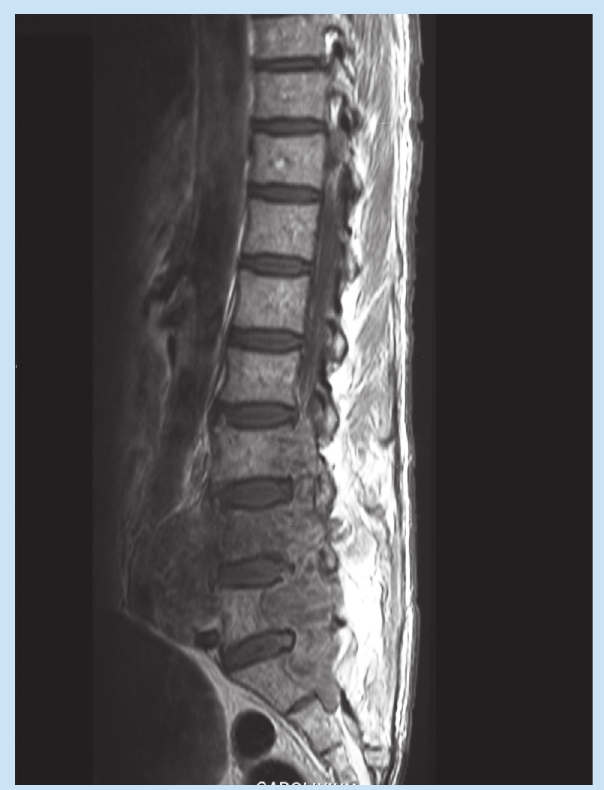
Fig. 3. T1 post gadolinium. Moderate inhomogeneous enhancement of the soft tissues.